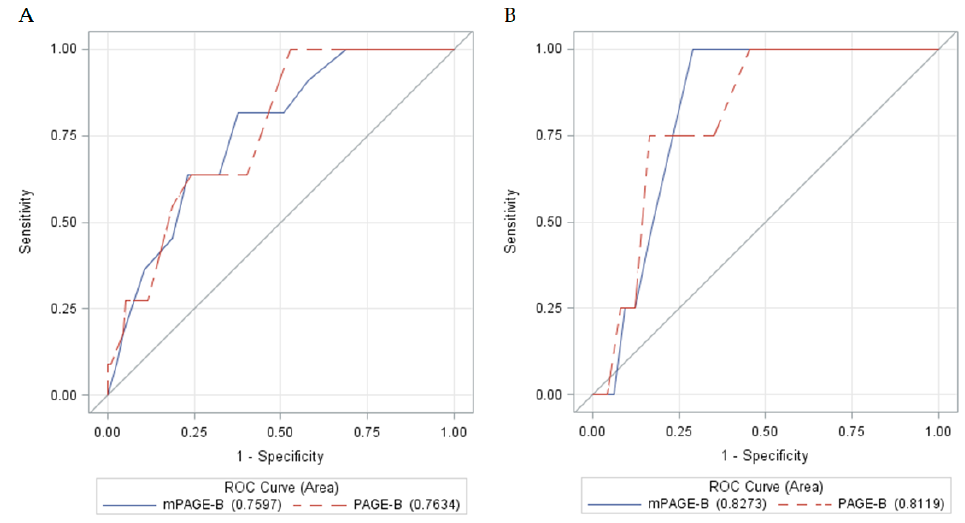
Figure 5. ROC curves of the initial PAGE-B and mPAGE-B scores stratified by HBV treatment during follow-up. ( A ): Patients that received HBV treatment ( p = 0.9451); ( B ): patients without treatment during follow-up ( p = 0.8138). HBV: hepatitis B virus; ROC: receiver-operating characteristic.